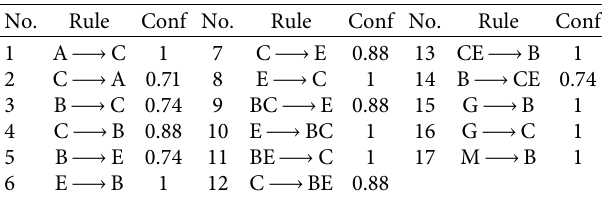
Table 13: Characteristics of datasets parts at three times.